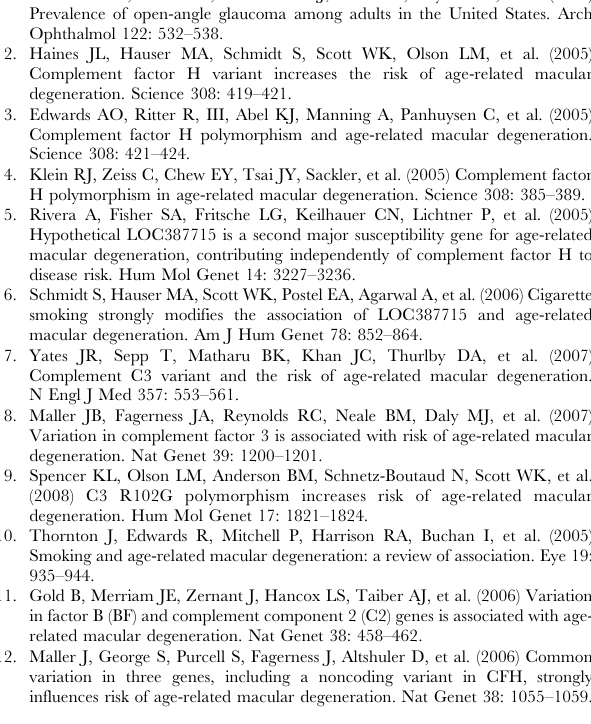
Figure S2 ROC analysis in the VM training dataset. Area under the ROC = 0.84 (95% confidence interval 0.81 to 0.88)